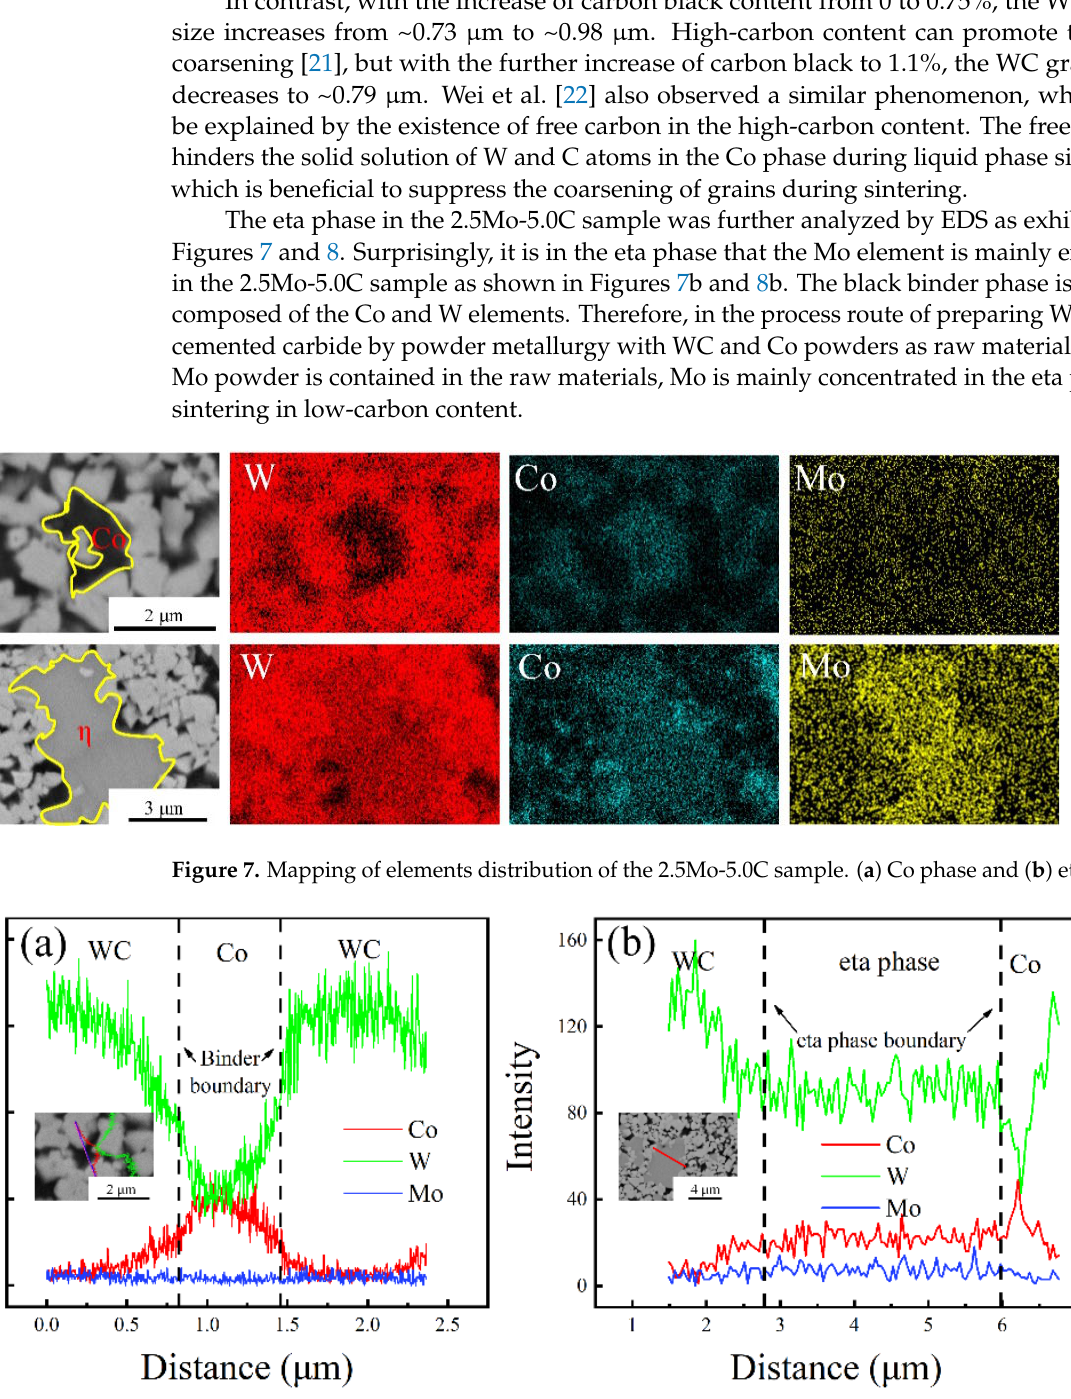
Figure 6. The grain size distribution in WC-13Co with different additions of Mo and C, ( a ) 0Mo- 5.13C, ( b ) 1Mo-5.07C, ( c ) 2Mo-5.01C, ( d ) 2.5Mo-5.0C, ( e ) 2.5Mo-5.3C, ( f ) 2.5Mo-5.45C, ( g ) 2.5Mo- 5.75C, ( h ) 2.5Mo-6.1C.